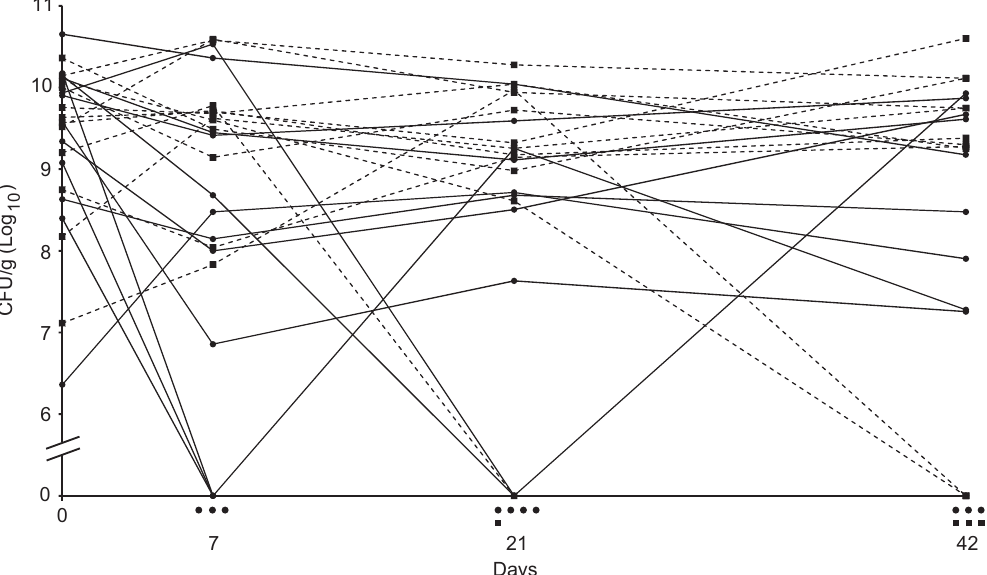
Figure 1. A randomised double-blind clinical trial of phage therapy against Pseudomonas aeruginosa otitis media. Patients were divided into two groups, one treated with phages (solid lines, (cid:1) ) and the other with placebo (dashed lines, (cid:3) ). There is a positive effect of the treatment in three patients as shown by non-detectable counts of the bacterium (CFU/g) after 7days, but the infection remains in the majority of patients as in most of the patients treated with placebo. Symbols under the x -axis indicate the number of patients in the two groups with non-detectable counts of P. aeruginosa at the different time points. Data from